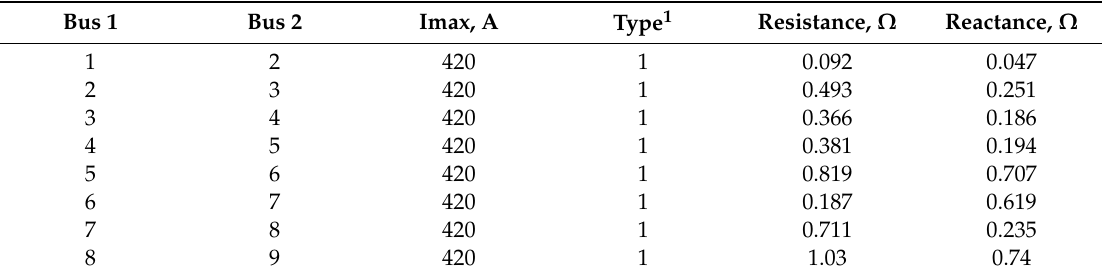
Table A1. Branch parameters for the IEEE 33-bus